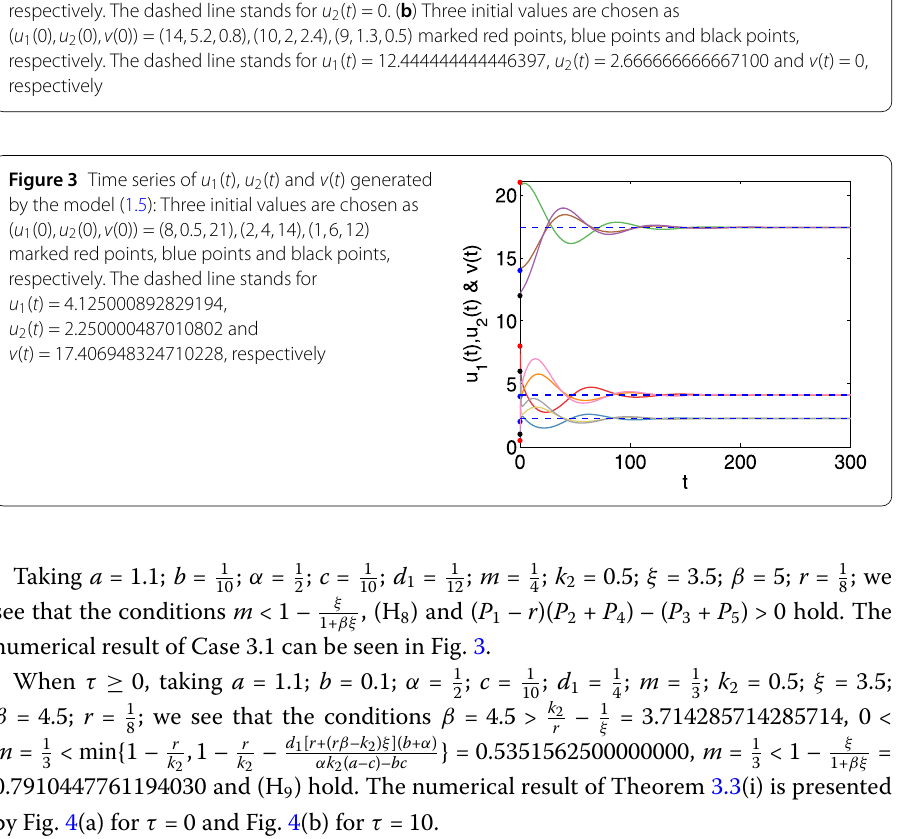
; α = 1 ; c = 1 ; d 1 = 1 ; m = 1 ; k 2 = 0.5; ξ = 3.5; β = 5; r = 1 10 2 10 12 4